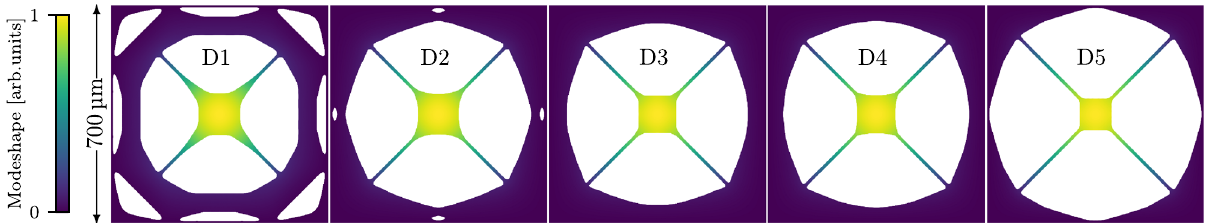
Fig. 2 Designs overview. Overview of topology optimized structures and the mode shape of their respective fundamental mode. Design D1 and D5 are optimized assuming only bending losses or phonon tunneling losses, respectively. Design D2 – D4 assume different weighted combinations of the two damping